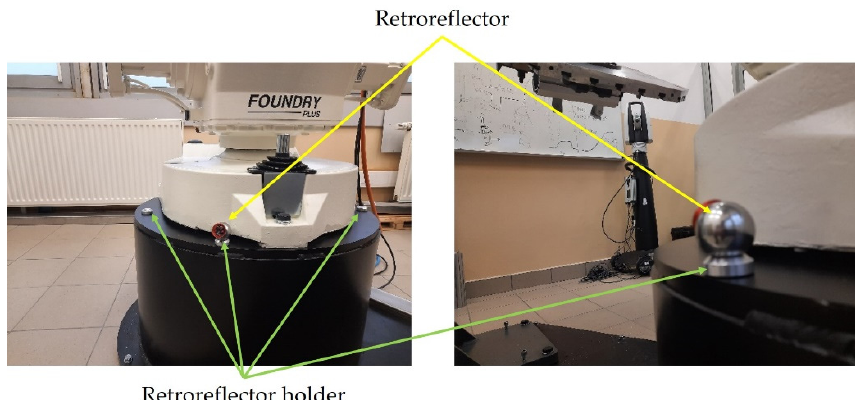
Figure 10. The location of the retroreflector holder.